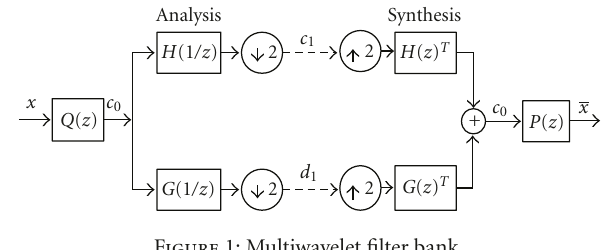
Figure 1: Multiwavelet filter